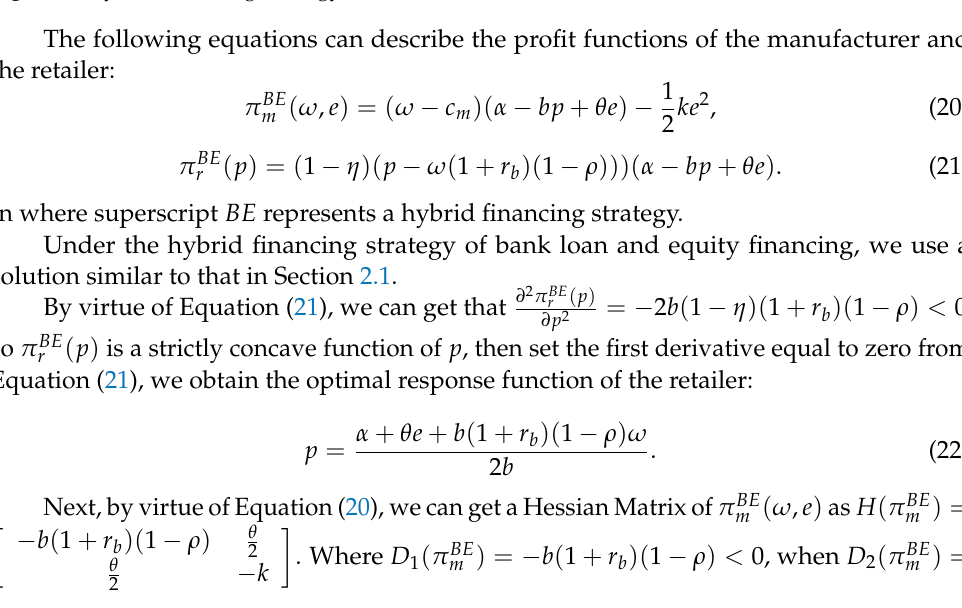
Figure 3. Hybrid financing